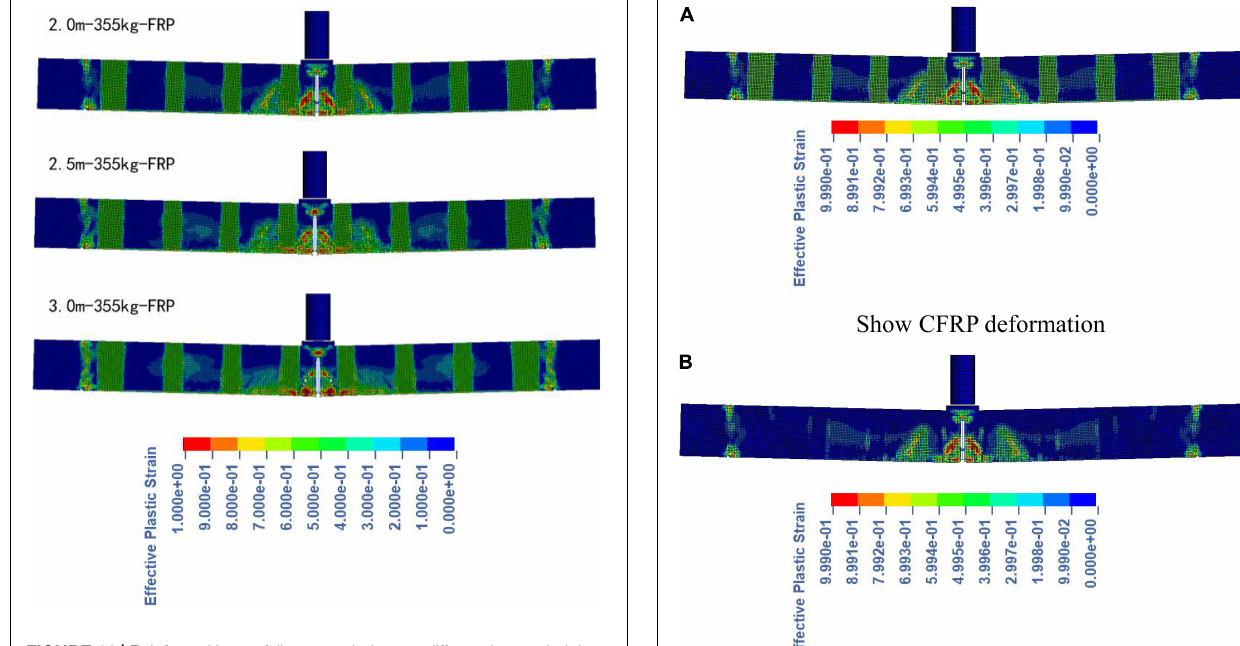
FIGURE 11 | Reinforced beam failure morphology at different impact heights.